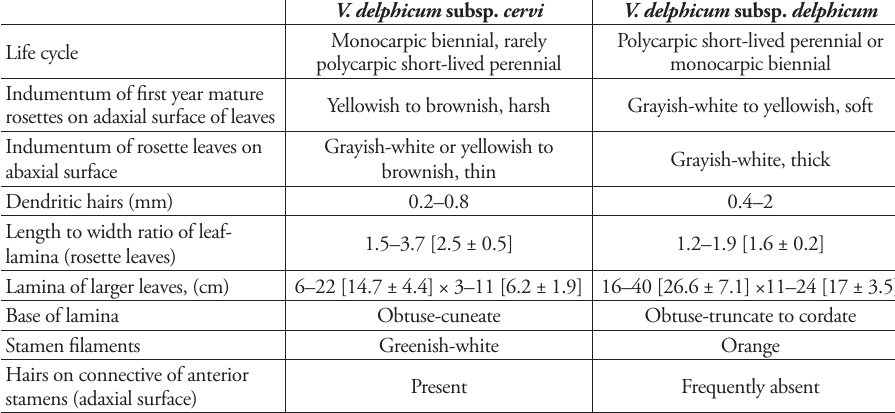
Table 1. Diagnostic characteristics of V. delphicum subsp. cervi and subsp. delphicum . Numbers in brackets indicate mean and standard deviation